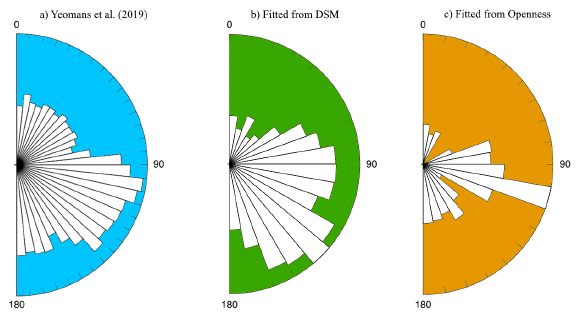
Figure 10. Comparison of half rose plots showing dominant ESE trends. a) shows regional polyline angles observed by Yeomans et al. (2019), b) shows polyline angles from lines fitted in this study using the model trained on the DSM representation and c) shows the polyline angles from lines